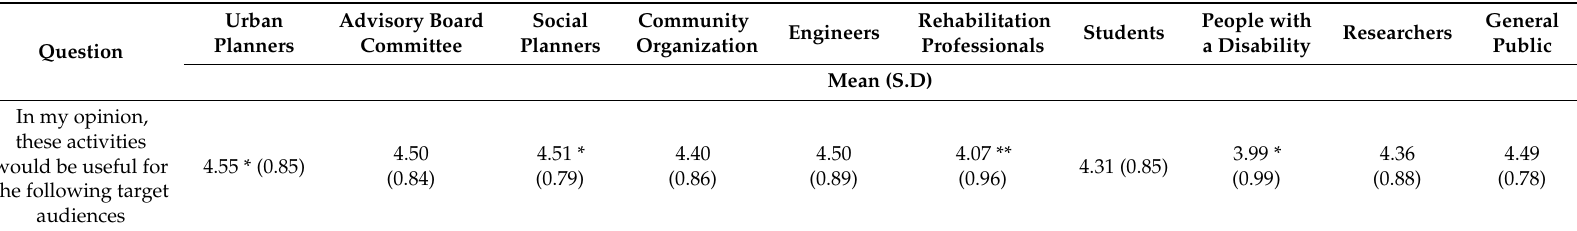
Table 4. Usefulness Evaluation of the KM Strategies by Audiences ( n =